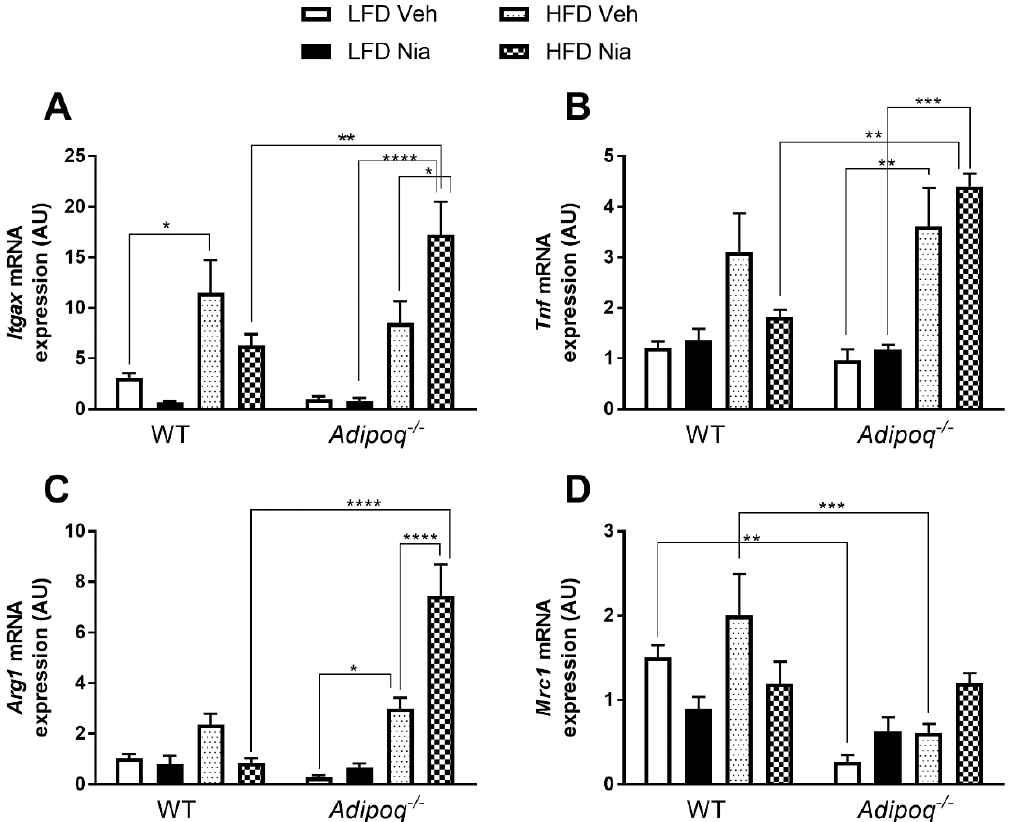
Figure 5. E ff ects of HFD and niacin on the gene expression of markers of adipose tissue macrophage polarity in EWAT. Relative gene expression of the M1 macrophage markers Itgax ( A ) and Tnf ( B ), and the M2 macrophage markers Arg1 ( C ), and Mrc1 ( D ) in wild-type and Adipoq - / - mice. All mRNA values were normalized to Rppl0 expression. Data are presented as mean + SEM. AU: arbitrary units. * p ≤ 0.05; ** p ≤ 0.01; *** p ≤ 0.001; **** p ≤ 0.0001; WT LFD Veh, n = 8; WT LFD Nia, n = 8; WT HFD Veh, n = 8; WT HFD Nia, n = 7; Adipoq - / - LFD Veh, n = 6; Adipoq - / - LFD Nia, n = 7; Adipoq - / - HFD Veh, n = 8; Adipoq - / - HFD Nia, n = 8.